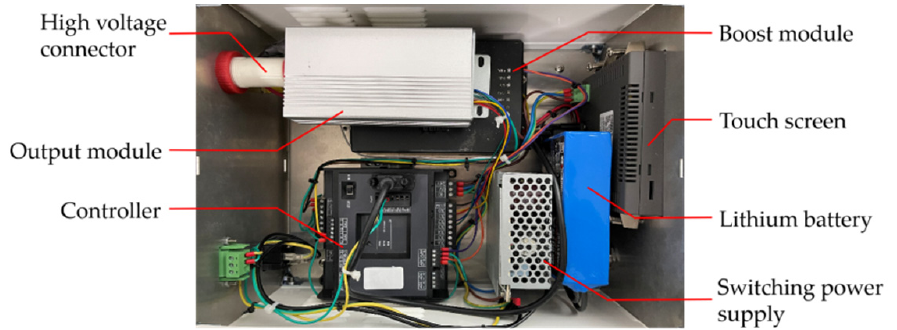
Figure 3. High-voltage system structure diagram.